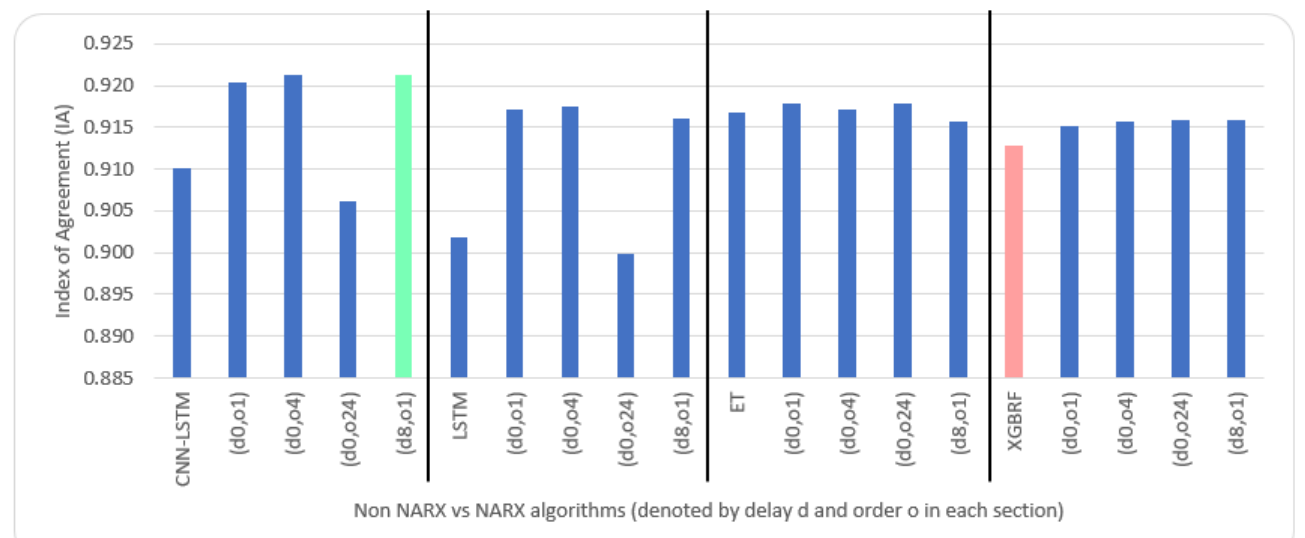
Figure 27. Evaluation results of non-NARX and NARX in terms of coefficient of determination for the Manchester dataset.